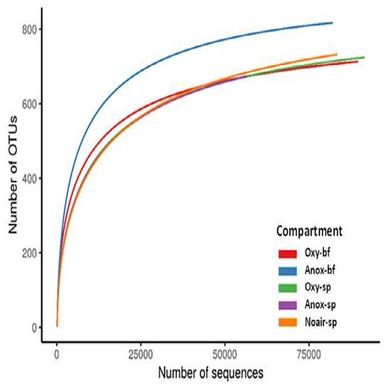
Rarefaction curves on sequencing data obtained from different compartments. The number of OTUs found in each specimen is reported as a function of the sequencing effort. Values were sampled using a step size of 100 assignments to generate smooth curves. The asymptotic trends of the curves indicate that the number of generated reads is representative of the whole community.